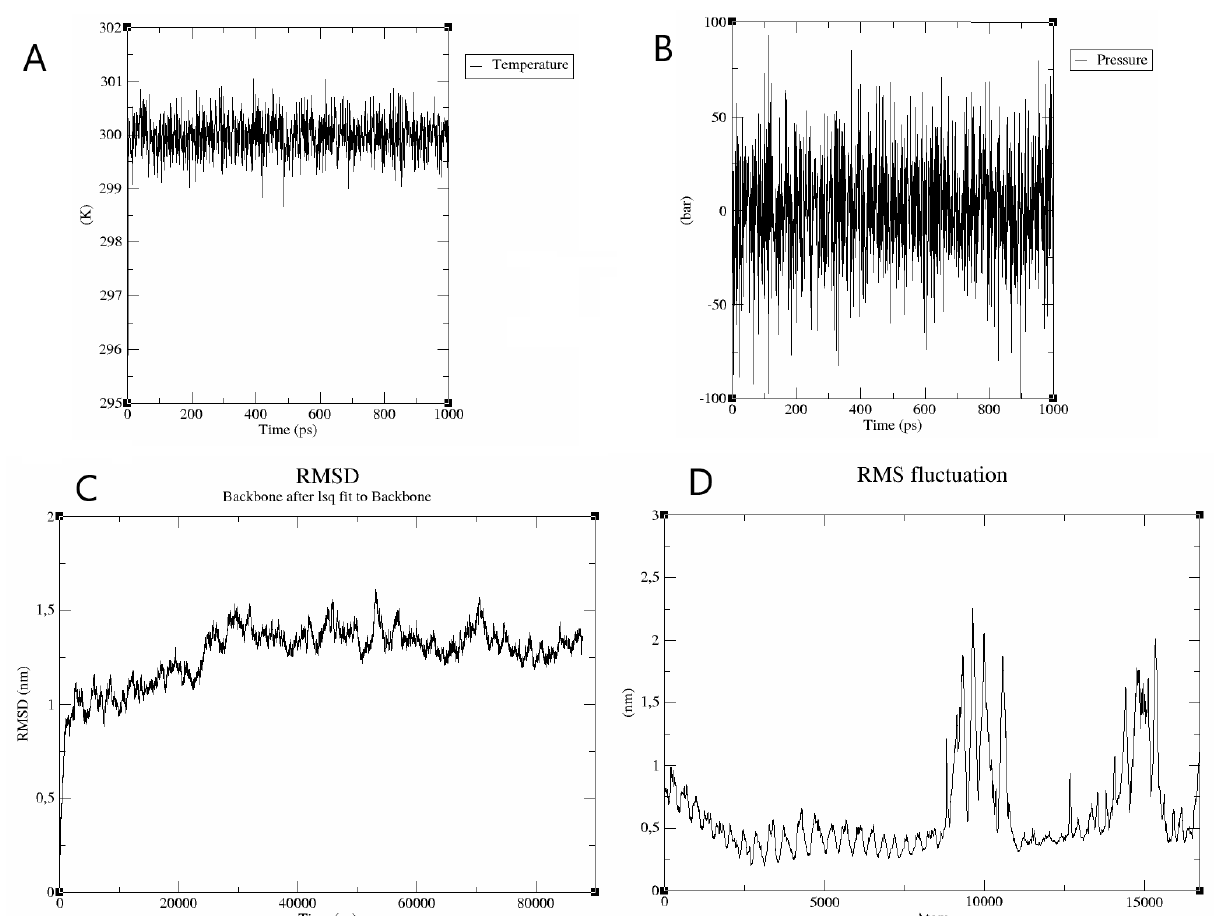
Figure 3. Molecular dynamics simulation plots for the Tpme-VAC/LGCM-2022-TLR2 complex. ( A ) The temperature plot shows that the temperature of the system reaches over 300 K, and fluctuates around 300 K throughout the equilibration phase (1000 ps). ( B ) The pressure plot displays pressure fluctuation during the equilibration phase (1000 ps), with an average pressure of 0.5 bar. ( C ) RMSD plot of the receptor-ligand complex shows no significant deviation, indicating a stable interaction. ( D ) RMSF plot shows mild fluctuations of about 0.5 nm and higher peaks with an RMSF value of 2, due to the highly flexible loop regions in the complex.